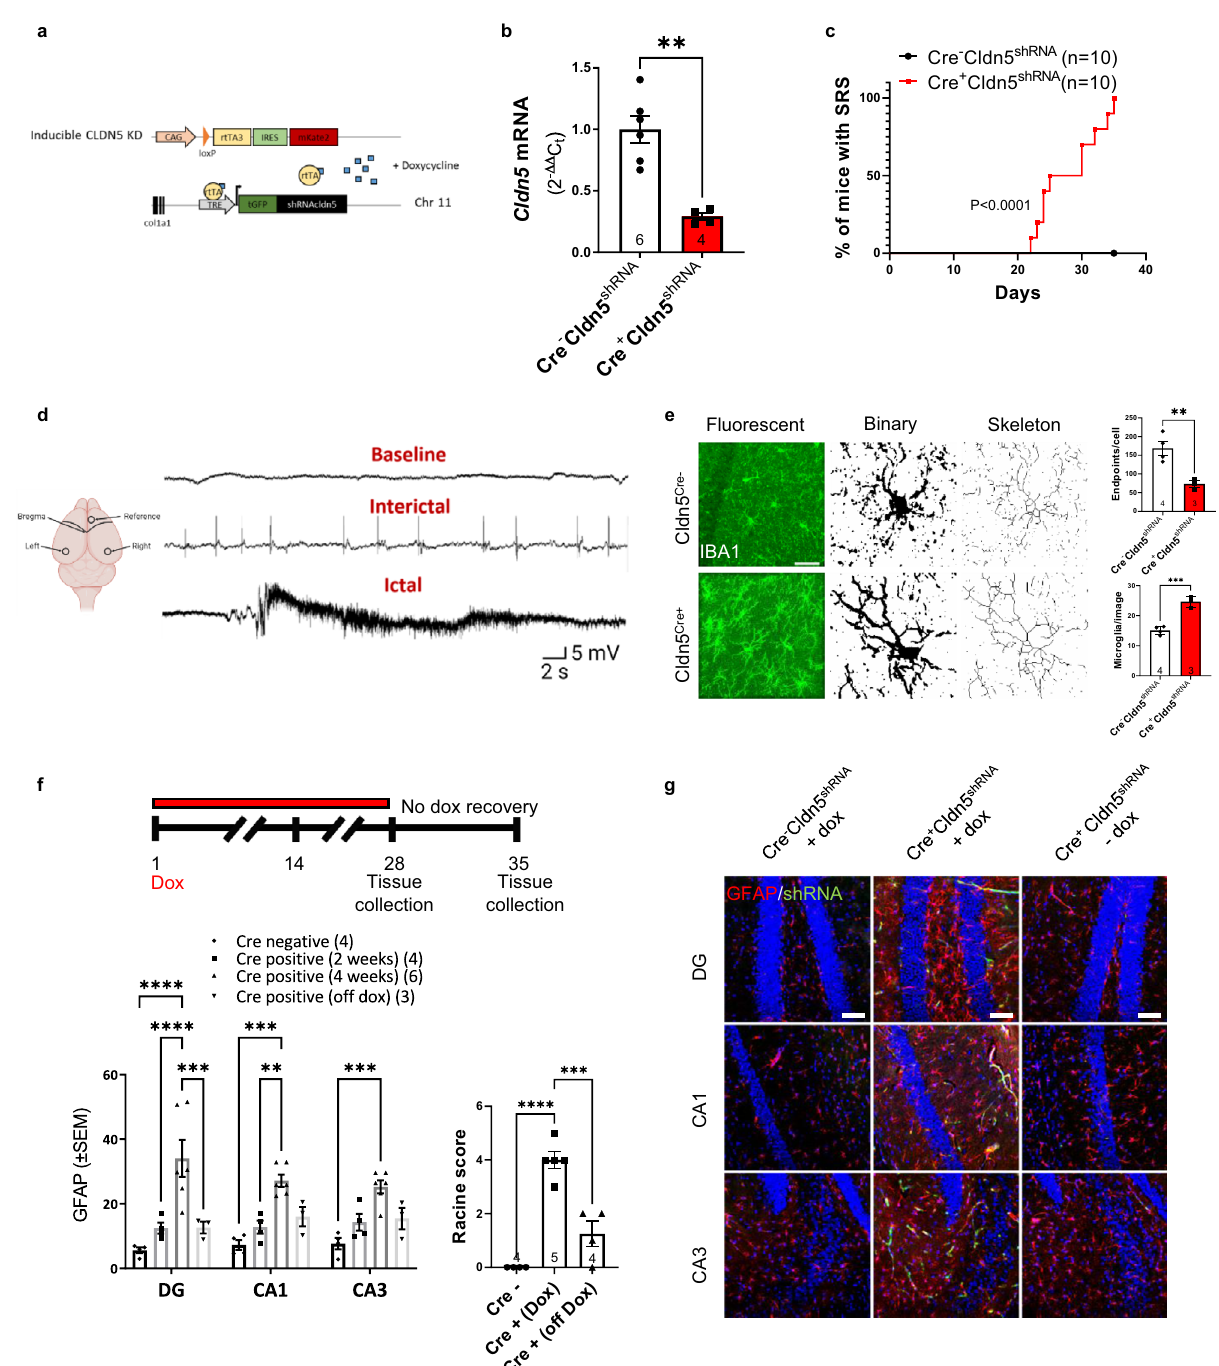
Fig. 4 Inducible Cldn5 knockdown mice develop spontaneous seizures and neuroin fl ammation. a Schematic outline of inducible knockdown mouse model. b Cldn5 signi fi cantly suppressed following 4 weeks of doxycycline (Dox) treatment (** p = 0.001). c Percentage of mice with spontaneous recurrent seizures (SRS) following 4 weeks of Dox treatment (**** p < 0.0001). d Representative EEG traces following 4 weeks of Dox treatment. e IBA1 (green) quanti fi cation post claudin-5 suppression with decreased cellular endpoints (** p = 0.0088), and increased IBA1 positive cells (*** p = 0.0005). Scale bar, 50 µ m. f , g Experimental outline for recovery experiment. Increased GFAP levels in the dentate gyrus (DG **** p < 0.0001), CA1 (*** p = 0.0001) and CA3 (*** p = 0.0007) of mice following 4 weeks of doxycycline treatment are reversed following doxycycline withdrawal in the DG (*** p = 0.0002 vs Cre positive 4 weeks). Scale bar, 100 µ m. Increased seizure behaviour as scored according to Racine scale (**** p < 0.0001 for Cre − vs Cre + (Dox)) decreased following Dox removal (*** p = 0.0004 for Cre + (Dox) vs Cre + (off Dox). Data represent means ± s.e.m.; each datapoint represents one animal. Number of animals ( n ) is indicated on graphs. Mantel – Cox test for SRS analysis; two-sided unpaired t -test for qPCR and microglia morphology; two-way ANOVA followed by Bonferroni ’ s multiple comparison test for reversibility study. ** p < 0.01; *** p < 0.001; **** p < 0.0001. Source data are provided as a Source Data fi